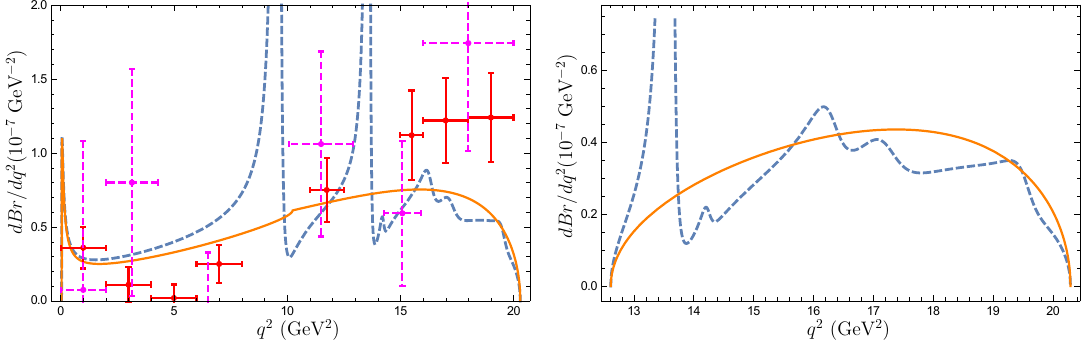
Λ µ + µ Λ Λ τ + τ − (left) and − b → →